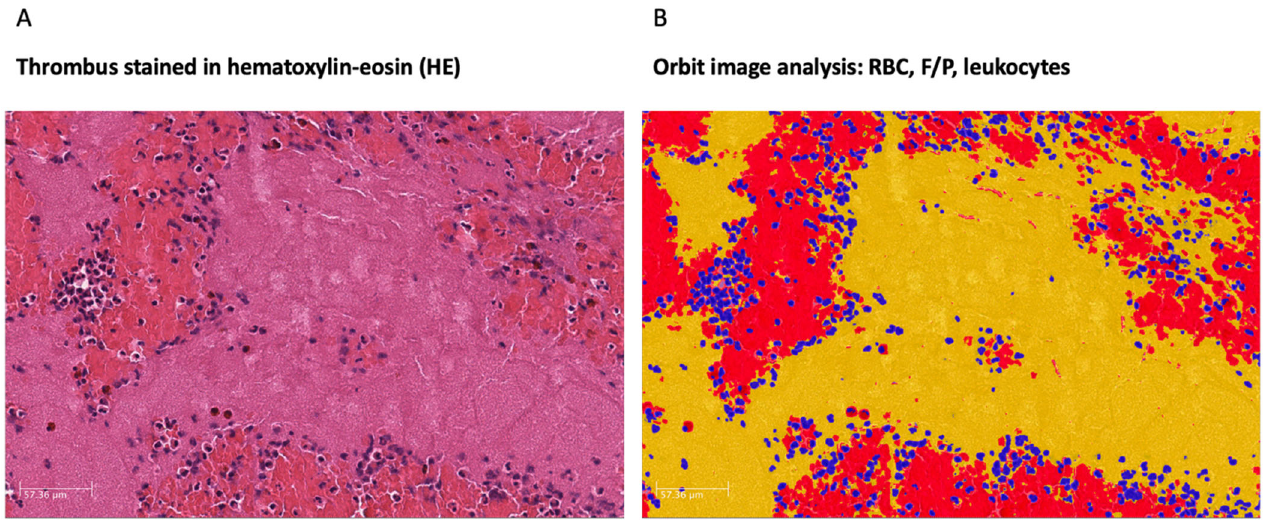
Figure 5. Exemplary histological clot analysis using orbit image analysis (OIA, www.orbit.bio (accessed on 18 July 2022)). ( A ) Cerebral clot in hematoxylin-eosin (HE) staining. Clots were fixed in phosphate-buffered 3.5% formalin and embedded in paraffin. Two µ m slices using a Microm HM 335 E microtome (Microm International GmbH, Walldorf, Germany) were cut. HE was performed following standard protocol. The slides were scanned at high resolution (400-fold) with a Leica AT2 scanner (Leica Biosystems, Wetzlar, Germany) and digitally stored. ( B ) Cerebral clot analysis using orbit image analysis. Red blood cell (RBC) count depicted in red. Fibrin/platelet (F/P) share depicted in yellow. Leucocytes depicted in blue. Relative share of the cerebral clot was calculated by